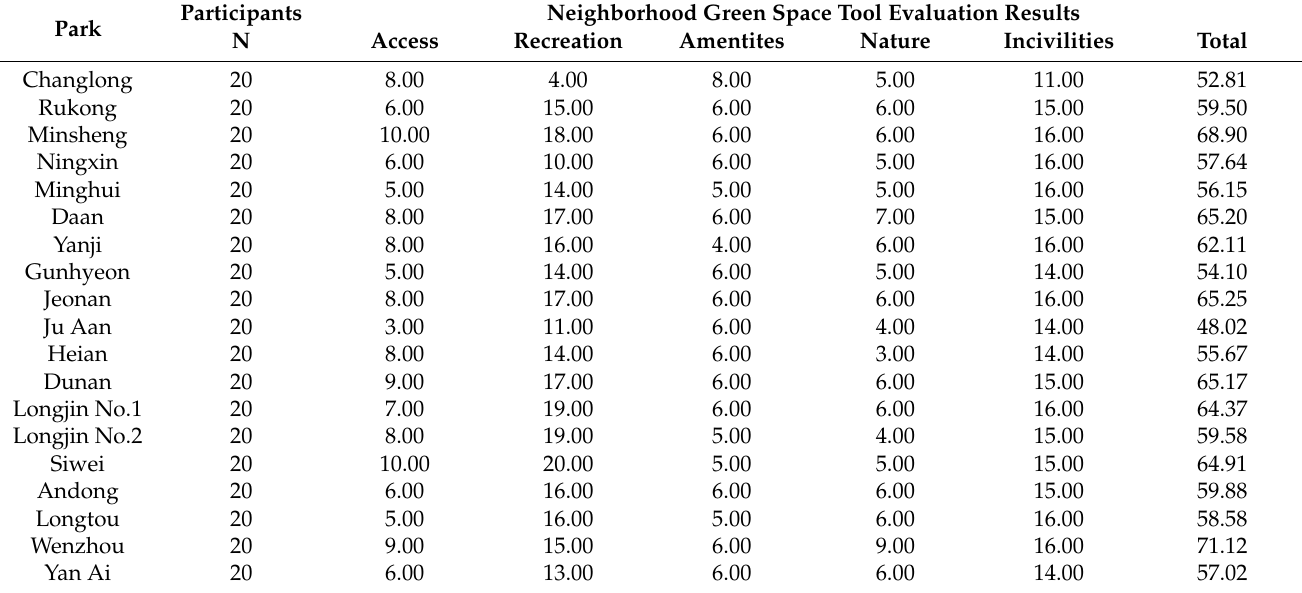
Table 4. Summary of the neighborhood park quality assessment results.